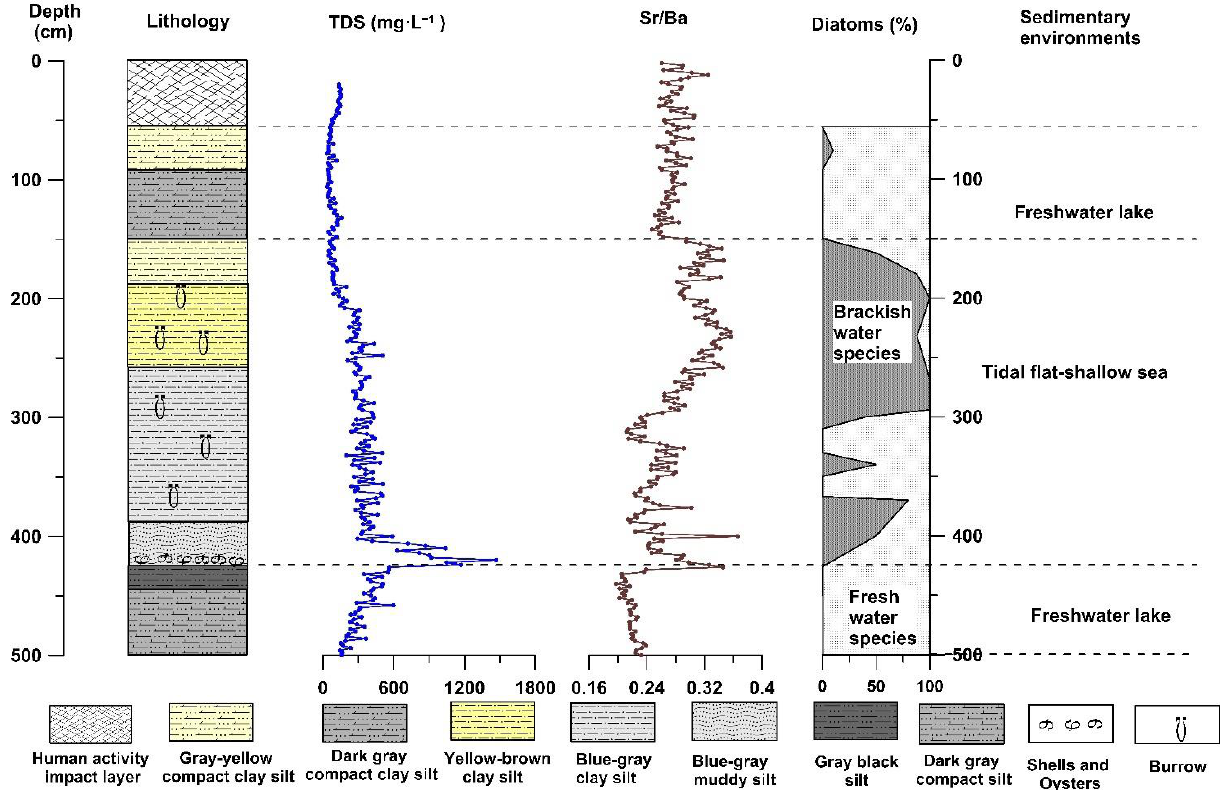
Table 2. Changes of Sr and Sr/Ba of sediment of GX and CYK profiles.